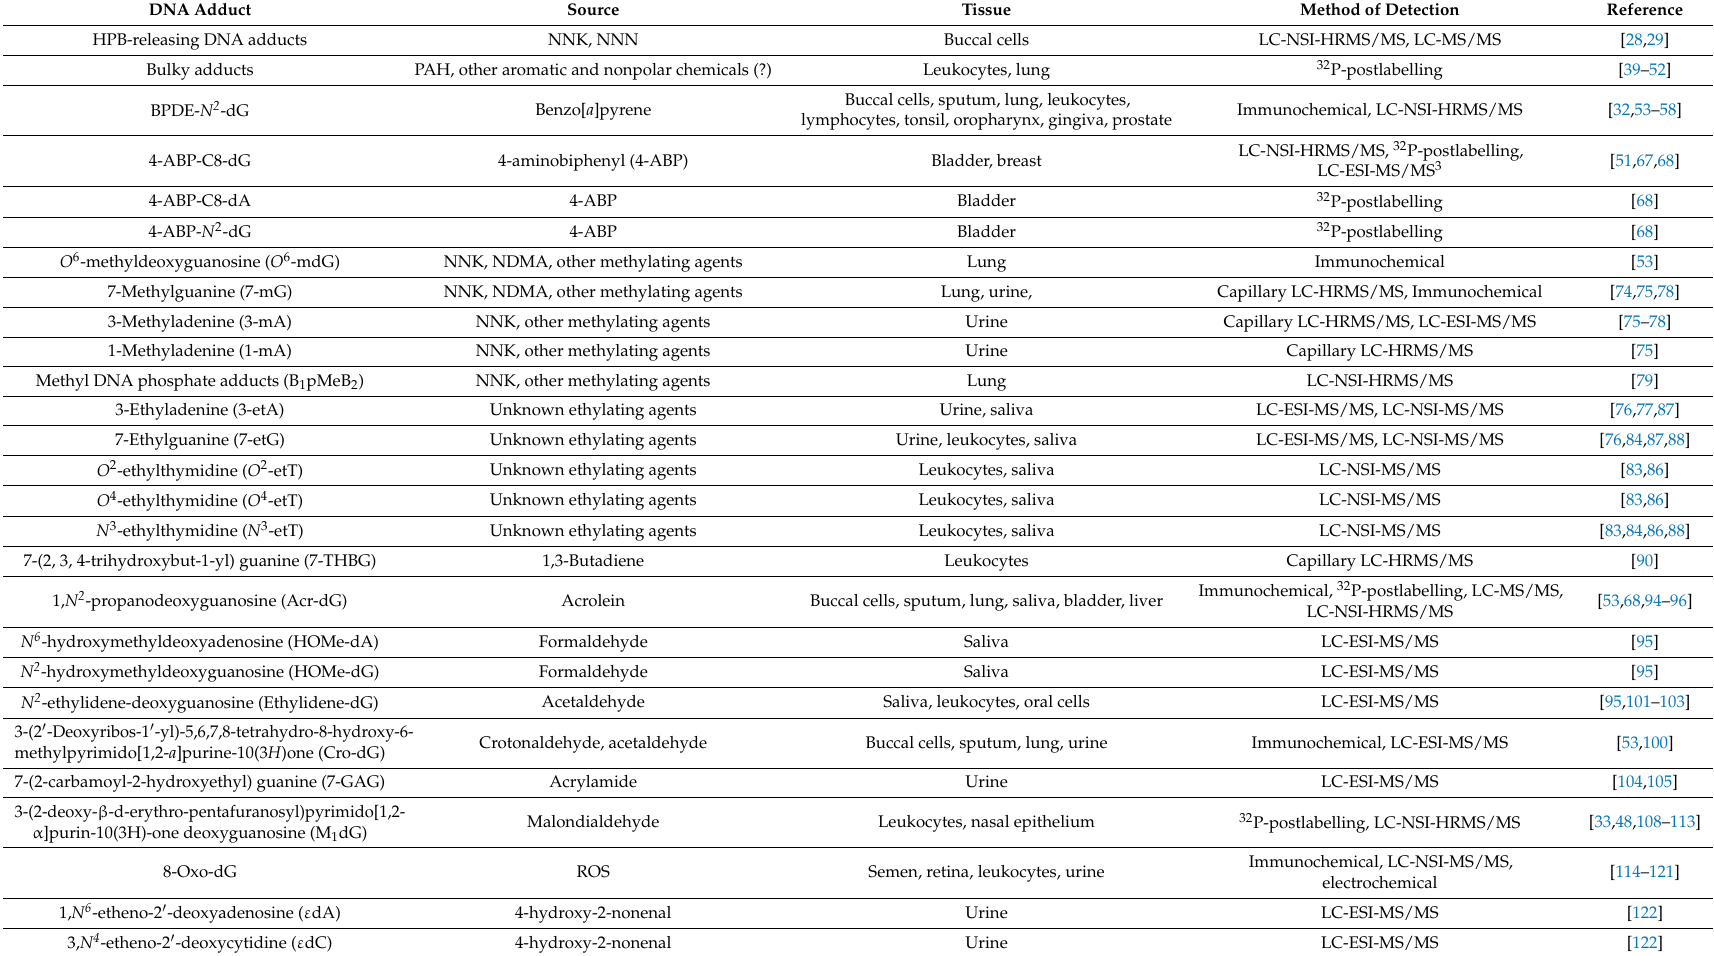
Table 1. Detection of tobacco smoke-related DNA adducts in human